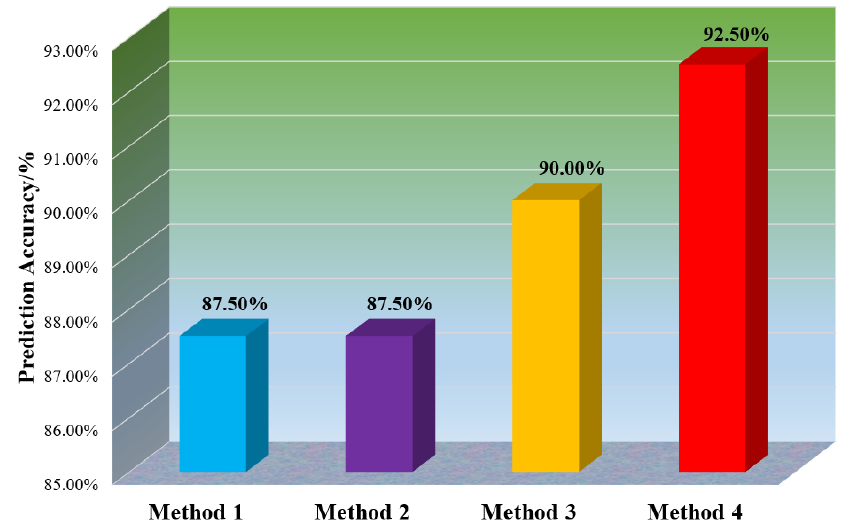
Figure 9. Comparison of the prediction accuracy.